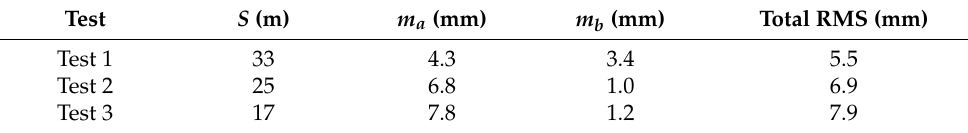
Table 7. Accuracy of displacement